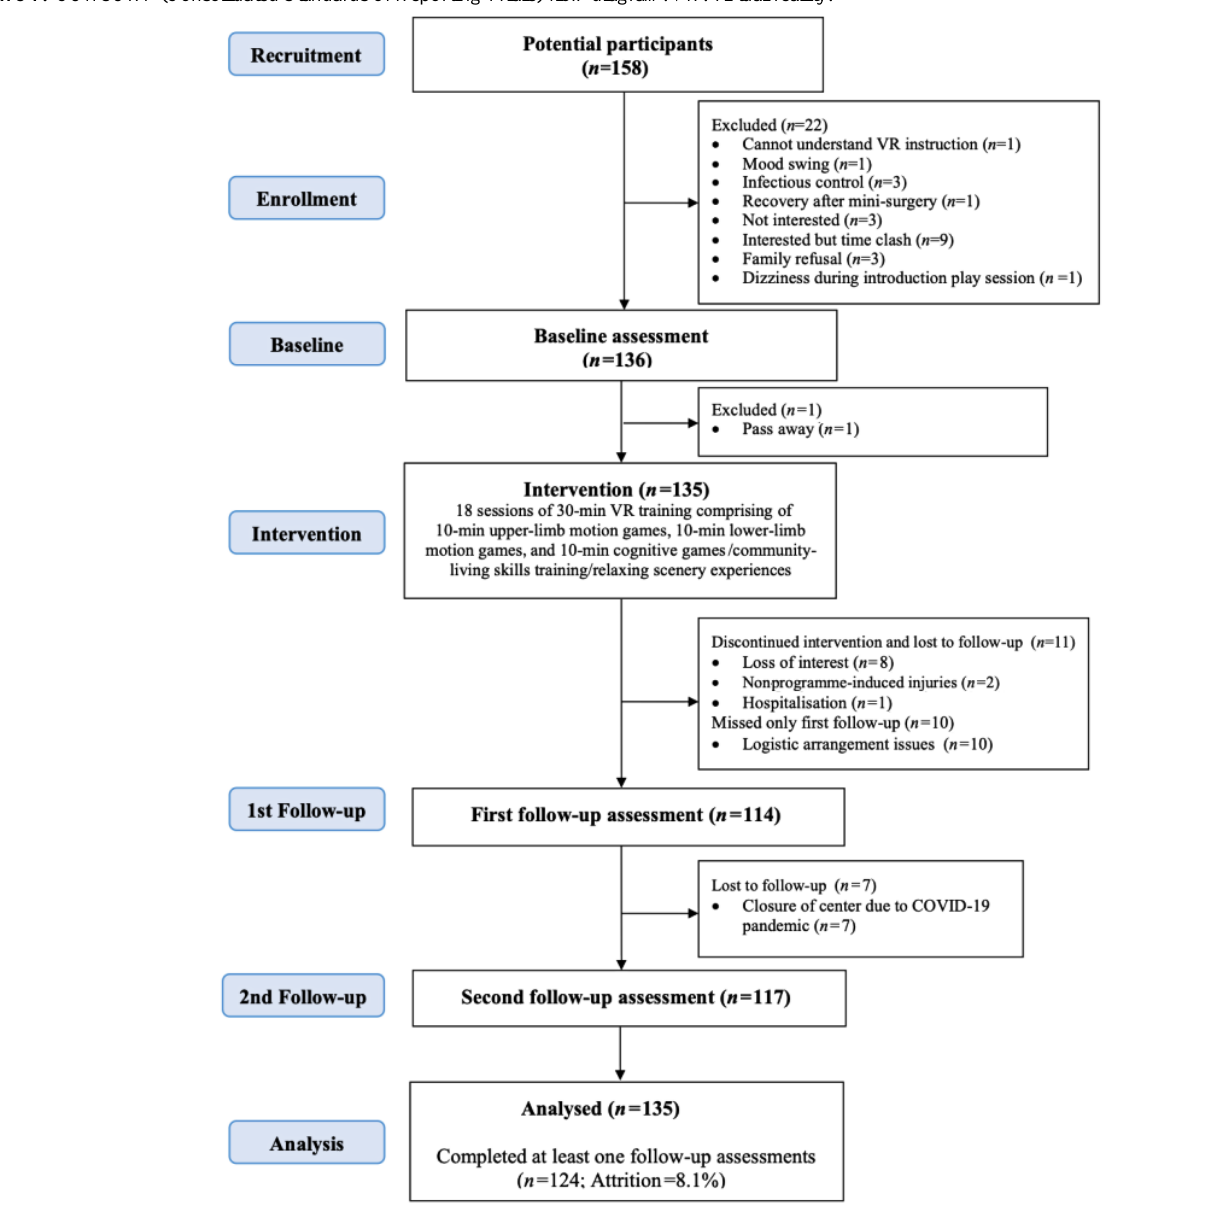
Figure 1. CONSORT (Consolidated Standards of Reporting Trials) flow diagram. VR: virtual